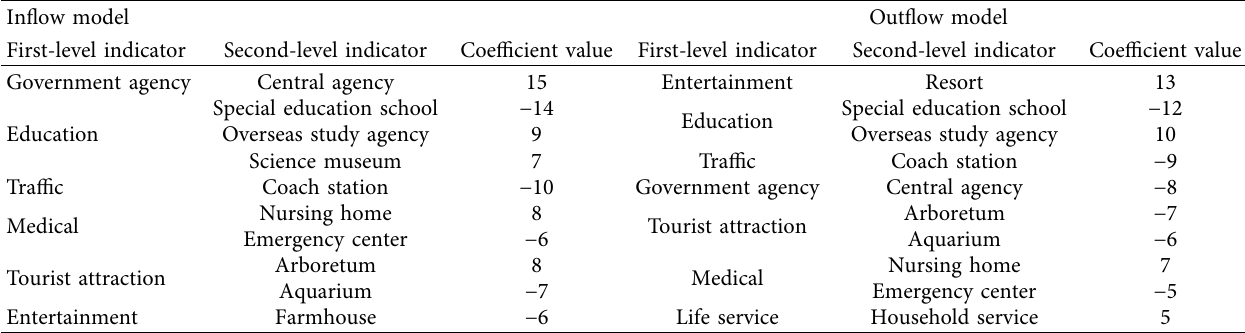
Table 12: Top 10 variables of the largest absolute value of coefficient in model during rush hours in the morning. Inflow model